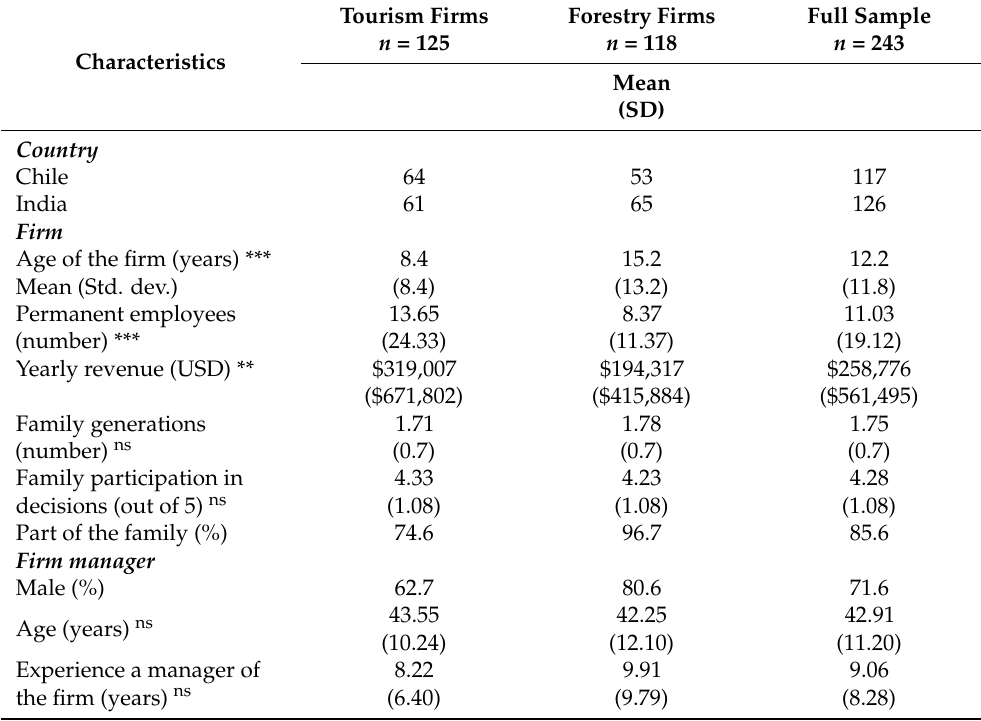
Table 2. Characteristics of the firms in the sample and firms of the tourism and forestry sectors.